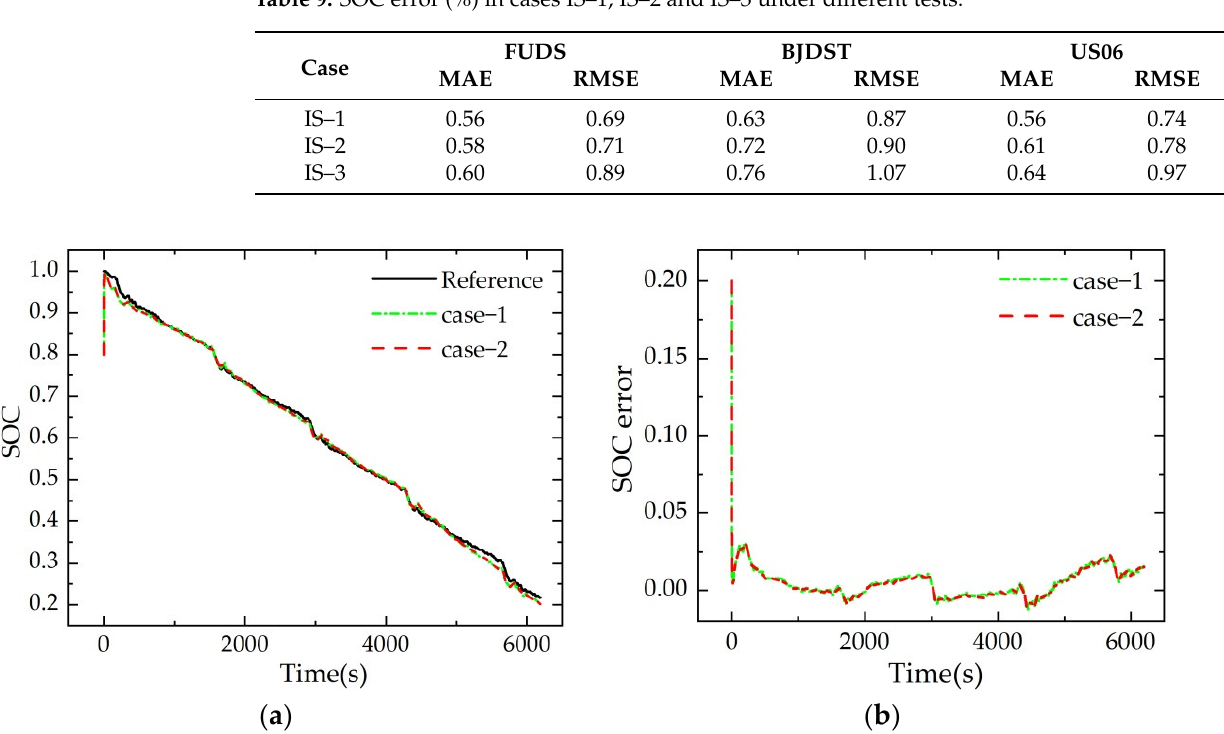
Figure 17. Comparison of the results of two cases under the FUDS test. The battery is A123–18650: ( a ) SOC estimation result; ( b ) SOC error. Table 10. SOC error (%) of two cases under the FUDS test.